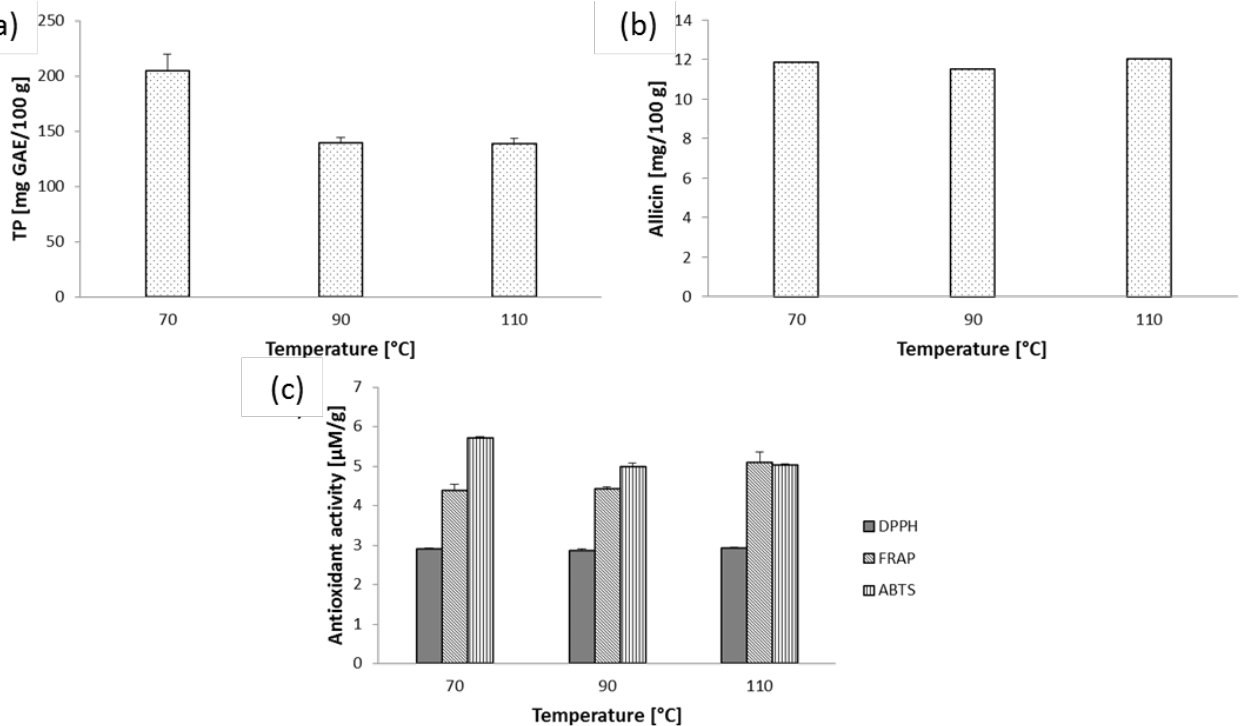
Figure 1. ( a ) TP, ( b ) allicin (AC) content and ( c ) antioxidant activity of A. sativum extracts obtained by SWE.